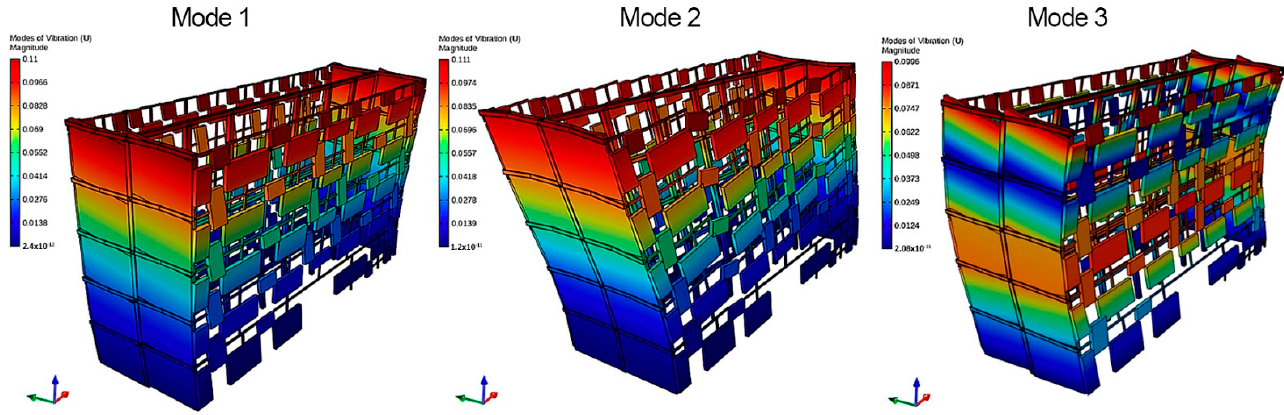
Figure 5. Modal shapes of the case study according to the first three modes of vibration. The results of NLS analyses are expressed in terms of single-degree-of-freedom (SDOF) capacity curves, normalised by dividing the shear force at the base ( V b ) and the